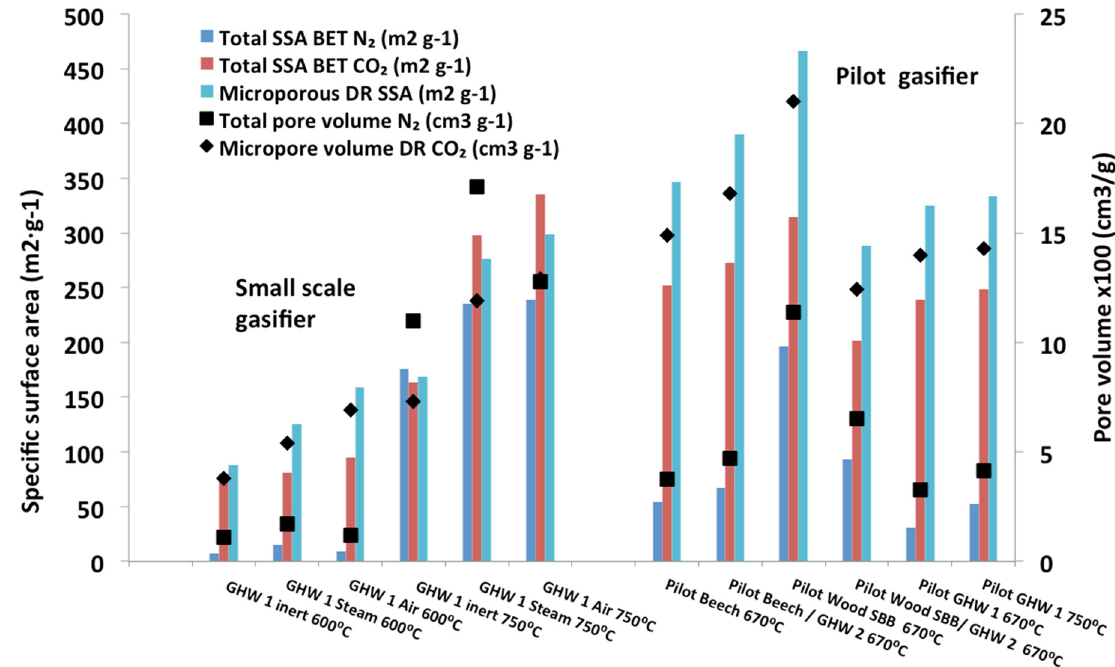
Figure 11. Overview of the N 2 and CO 2 –measured surface area and pore volume. The six bars on the left-hand side represent biochars produced in the smaller gasifier while the six samples on the right-hand side are from the larger scale gasifier. Temperatures and gaseous environments of the production procedures are indicated on the